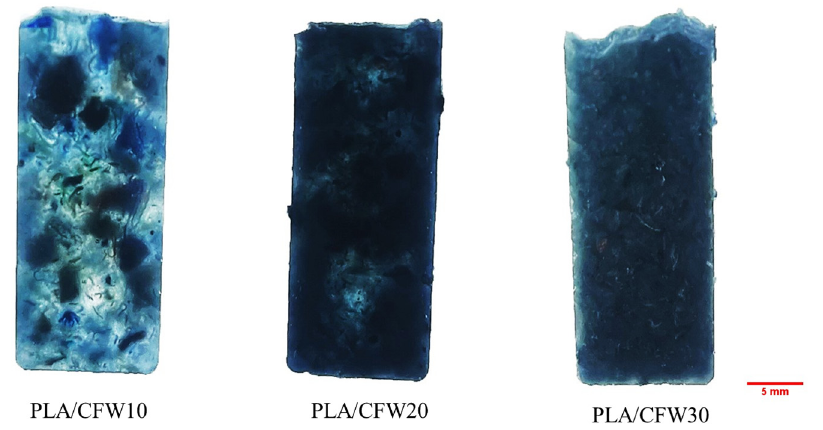
Figure 4. The appearance of PLA/CFW.